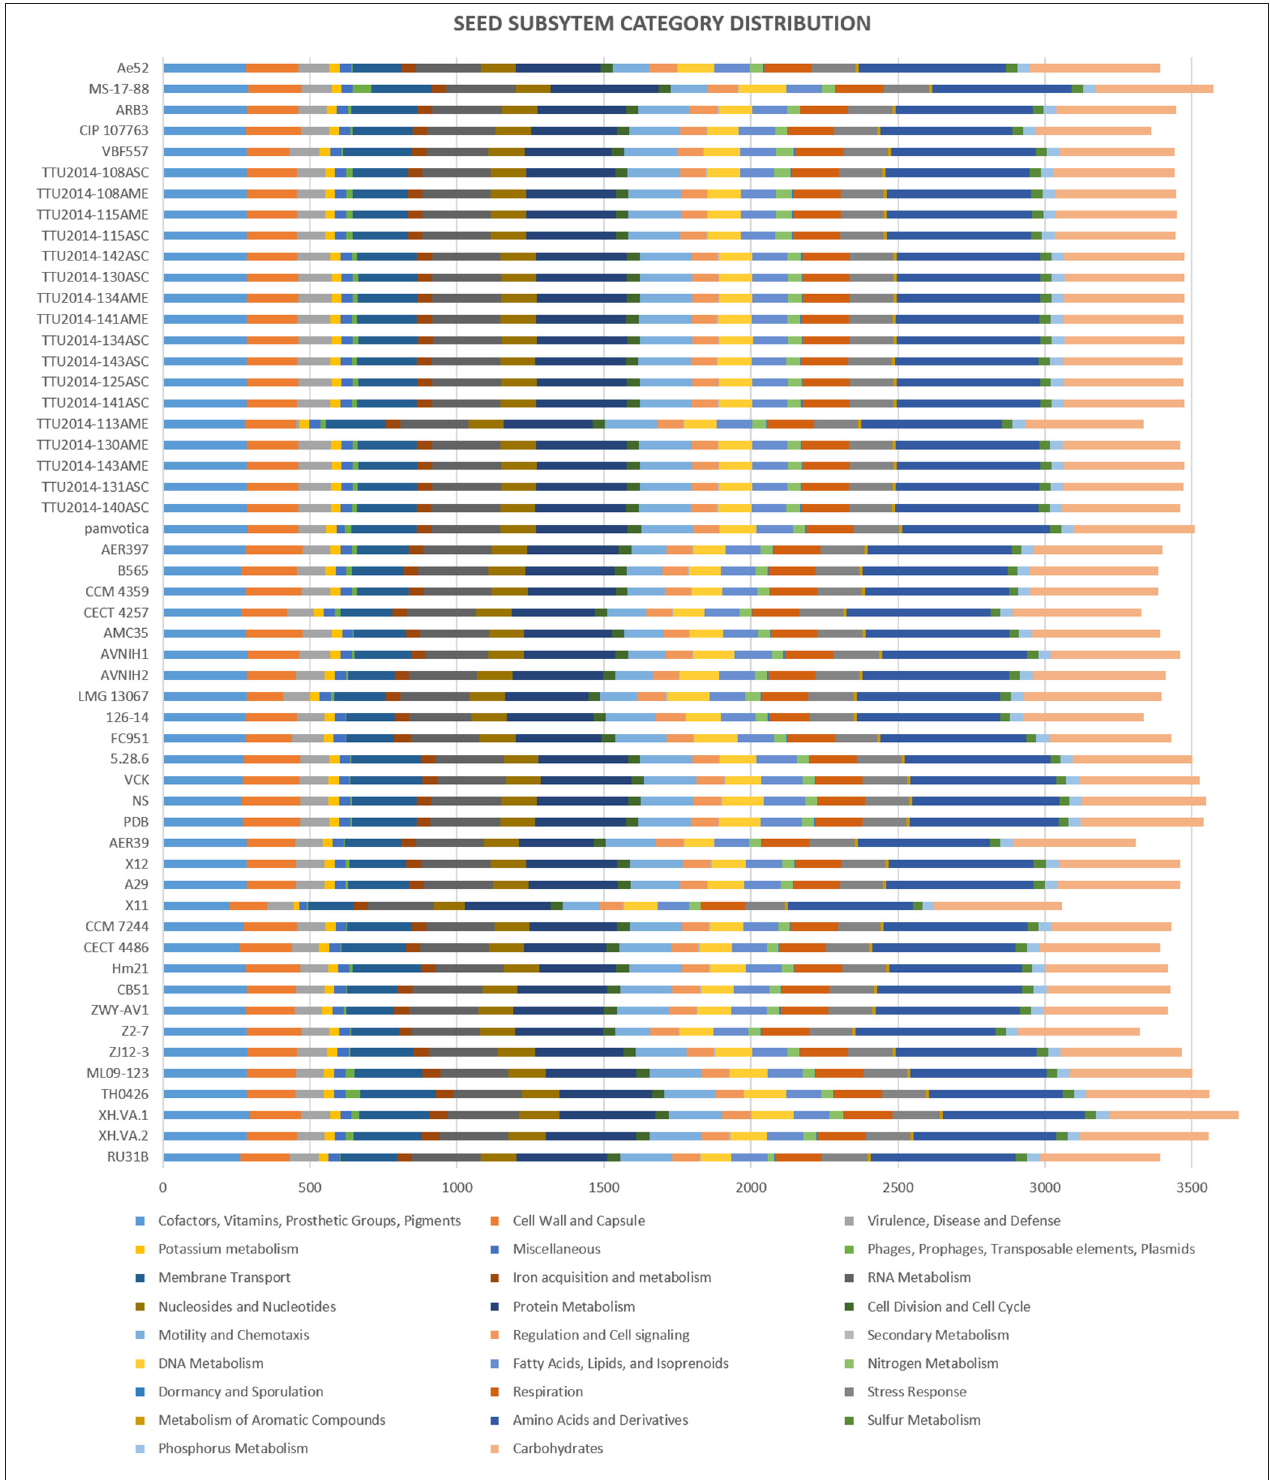
FIGURE 2 | Comparison of functional categories in 53 A. veronii genomes based on SEED. Functional categorization is based on roles of annotated and assigned genes. Each colored bar represents the number of genes assigned to each category.